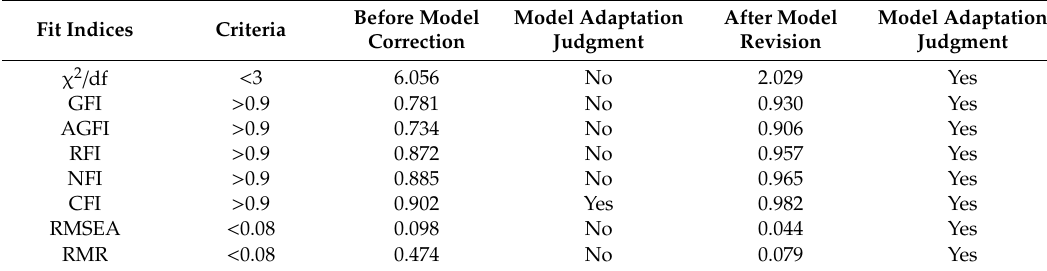
Table 5. Measurement of model fit indices.